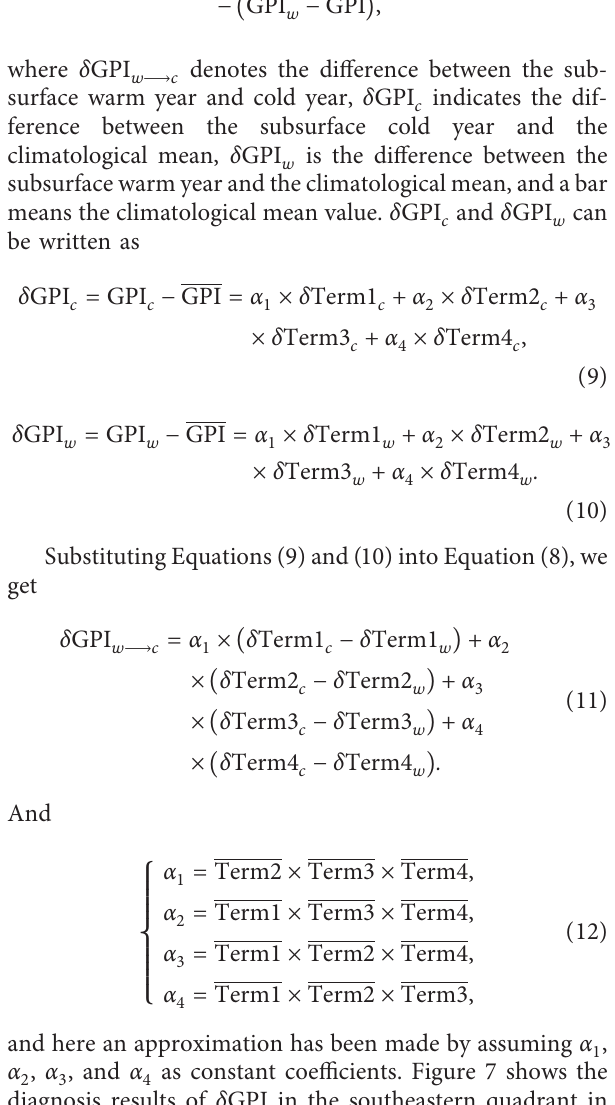
Figure 6: The composite difference of (a) GPI The cross sign indicates that the difference is statistically significant at the 95% confidence